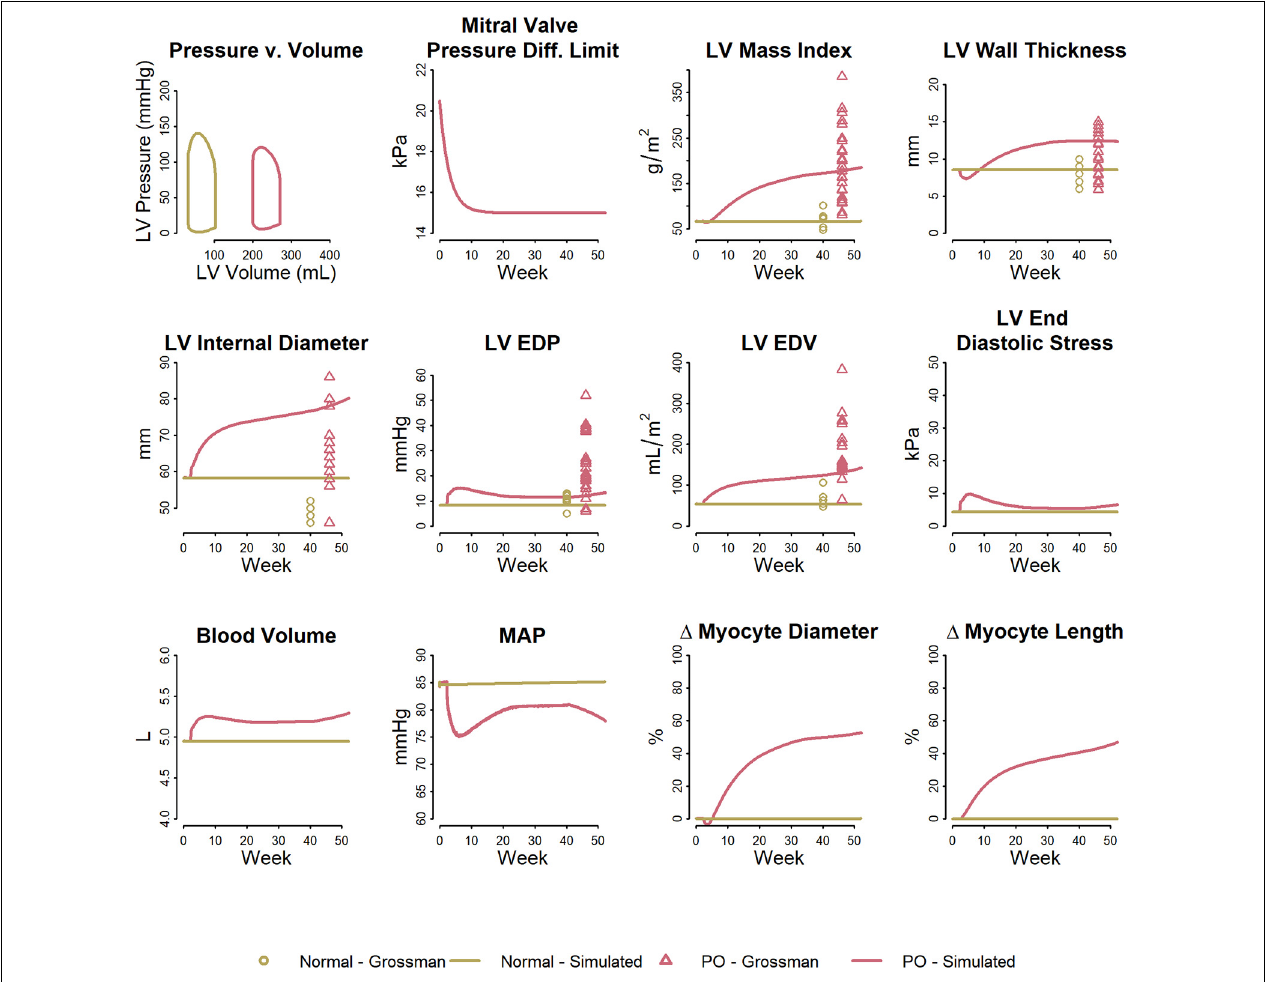
FIGURE 5 | Model reproduces observed patterns of hypertrophy in volume overload due to mitral regurgitation. Data from Grossman et al.